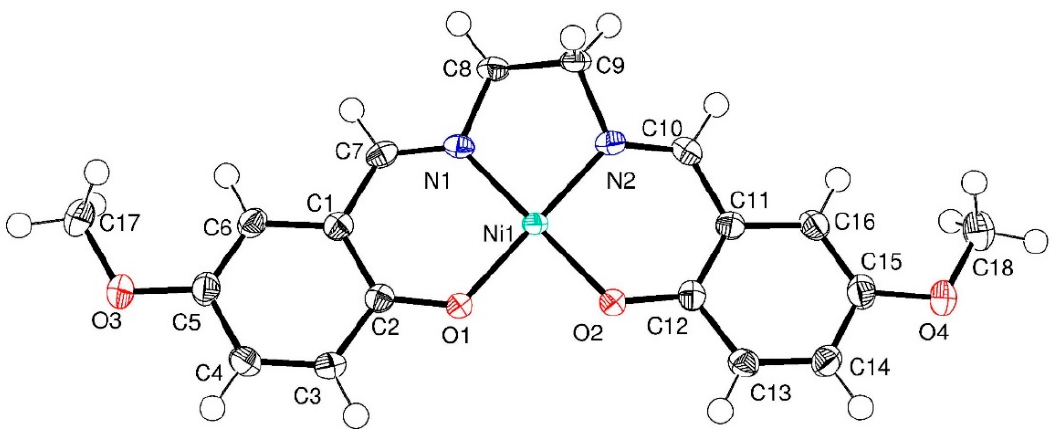
Figure 3. Perspective of the compound NiMeO salen with a displacement ellipsoid at a 50% probability level for non-H atoms.